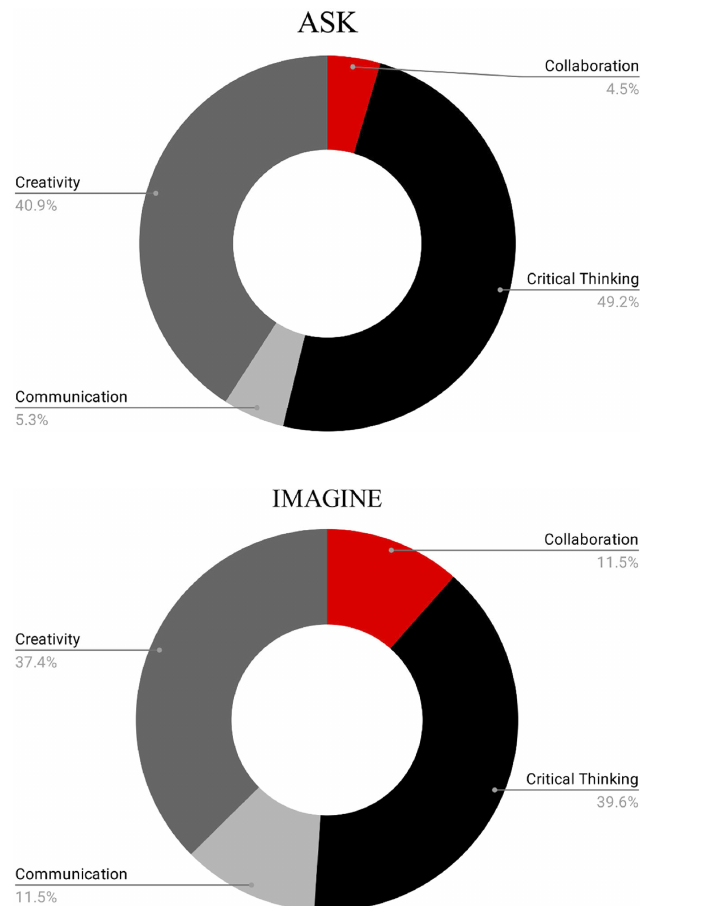
Figure 6. Percentages of